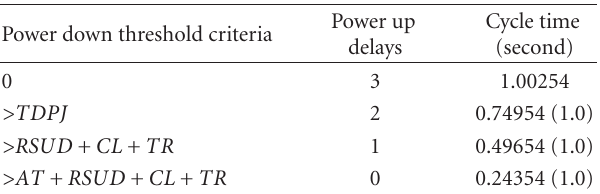
Table 14: Power Down Threshold cases for an open system and their associated cycle